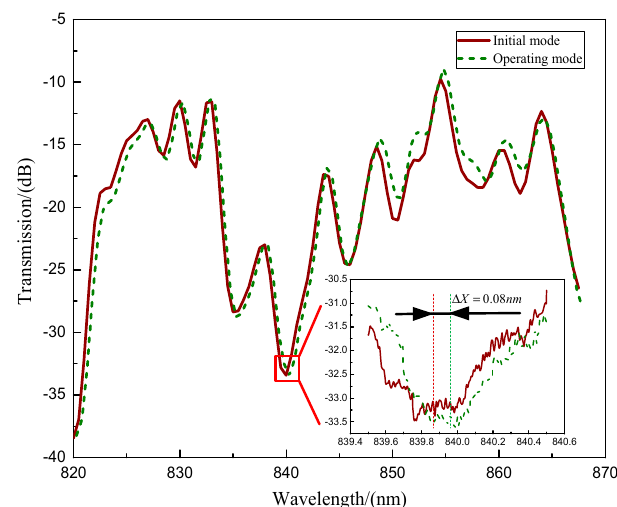
Figure 17. The frequency response test results.